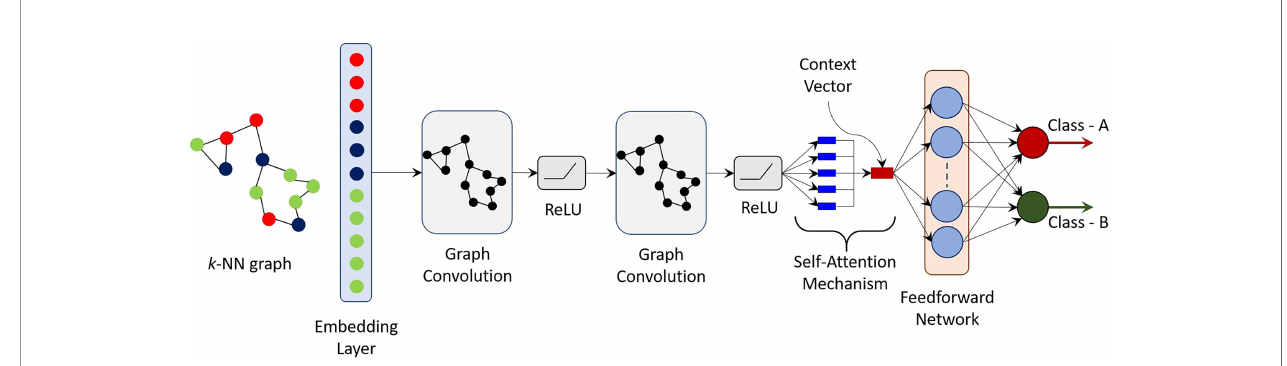
FIGURE 2 | Schematic of the proposed cellular graph attention network (CGAT). Based on the geometrical coordinates of the epithelial and immune cells, a k -NN graph is constructed and passed through an embedding layer, which converts cell types labels to a d-dimensional vector. The output of the embedding layer is passed through a GCN with self-attention mechanism. The context vector is fi nally fed to a simple feed forward network, which maps the input graph to one of the two classes. For the multi-class classi fi er, 15 such pre-trained pairwise classi fi ers (one for each combination of classes) are bootstrapped in a rule-based